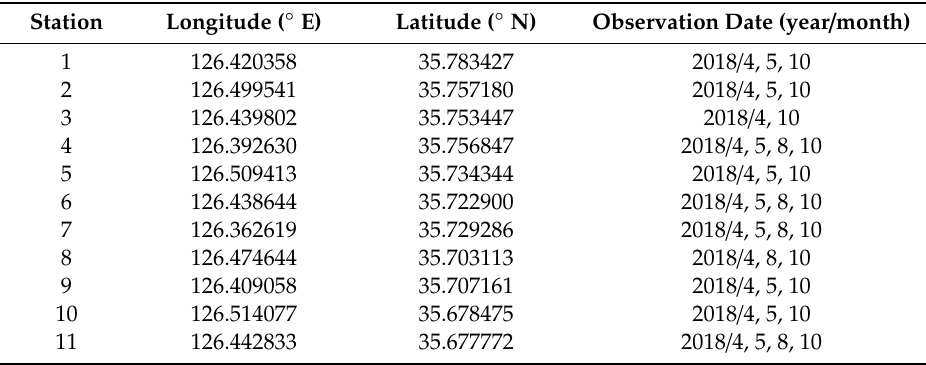
Table 1. The in-situ sites used in this